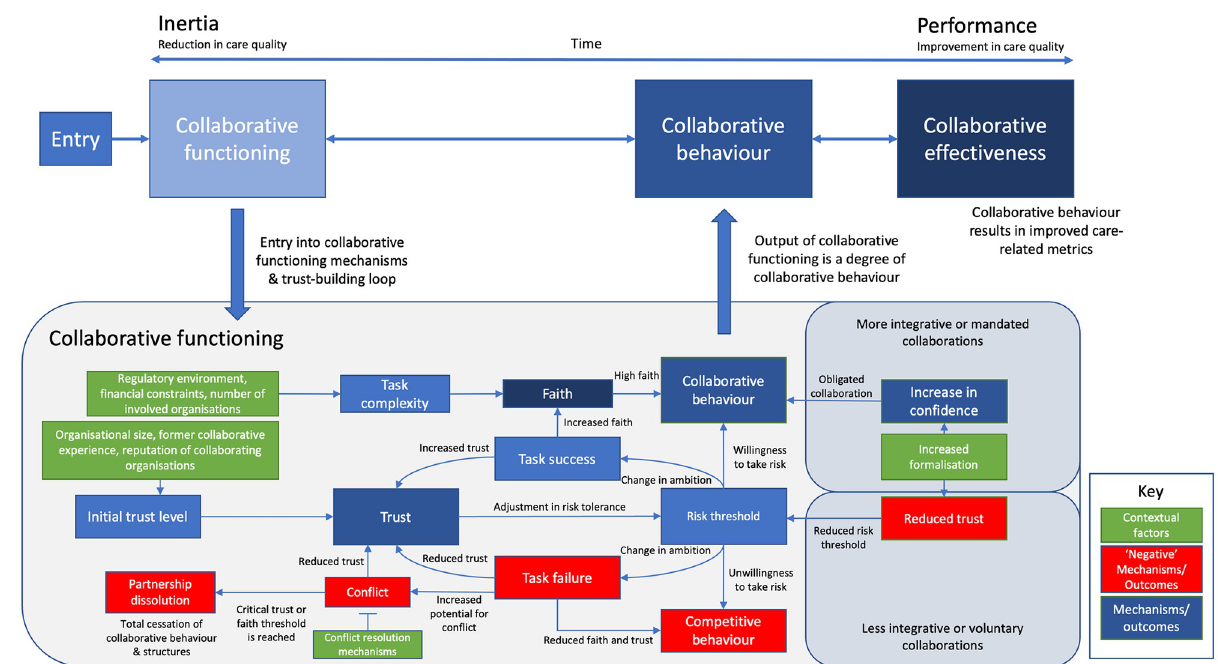
Fig 2. Existing programme theory/theoretical framework based on Aunger, Millar & Greenhalgh (2021) [3]. Originally published by Springer Nature (BMC Health Services Research). Reproduced with permission from the copyright holders.